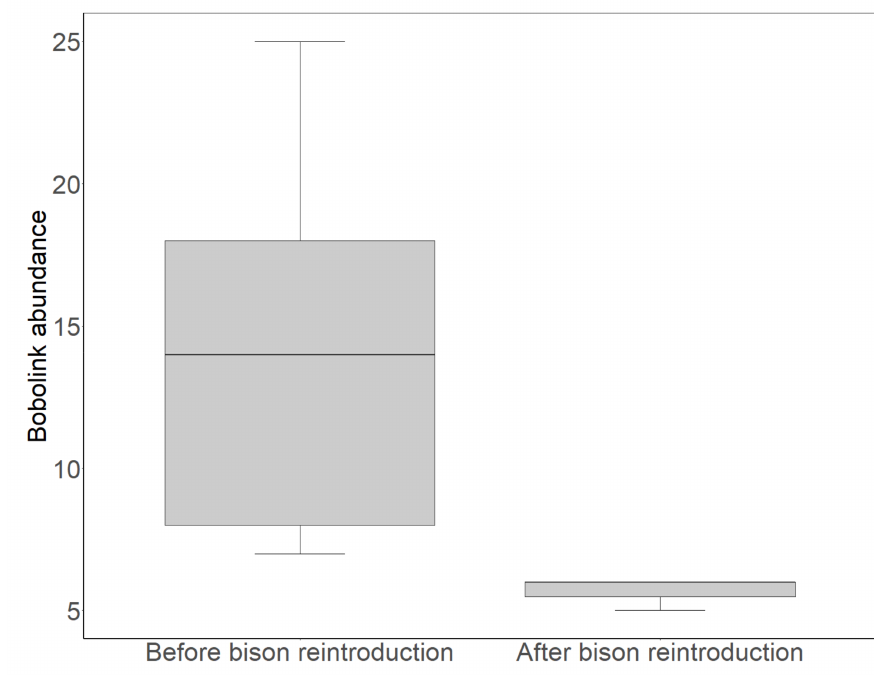
Figure 2. Boxplot showing Bobolink abundance (unique adult individuals captured/year) before (2002–2007) and after (2017–2019) bison reintroduction (2015) on conservation grasslands in Nebraska, USA. Black lines in boxes represent median values of abundance, while the lower and upper box edges represent the 25th and 75th percentile of the abundance, respectively. Error bars represent the 5th and 95th percentiles of the abundance.